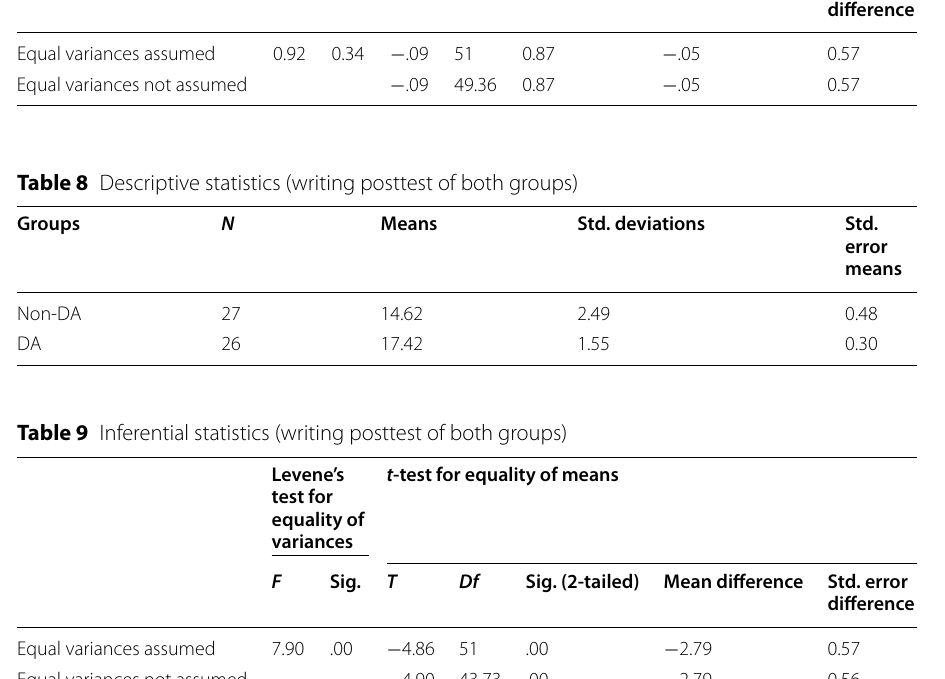
Levene’s t -test for equality of means test for equality of variances F Sig.